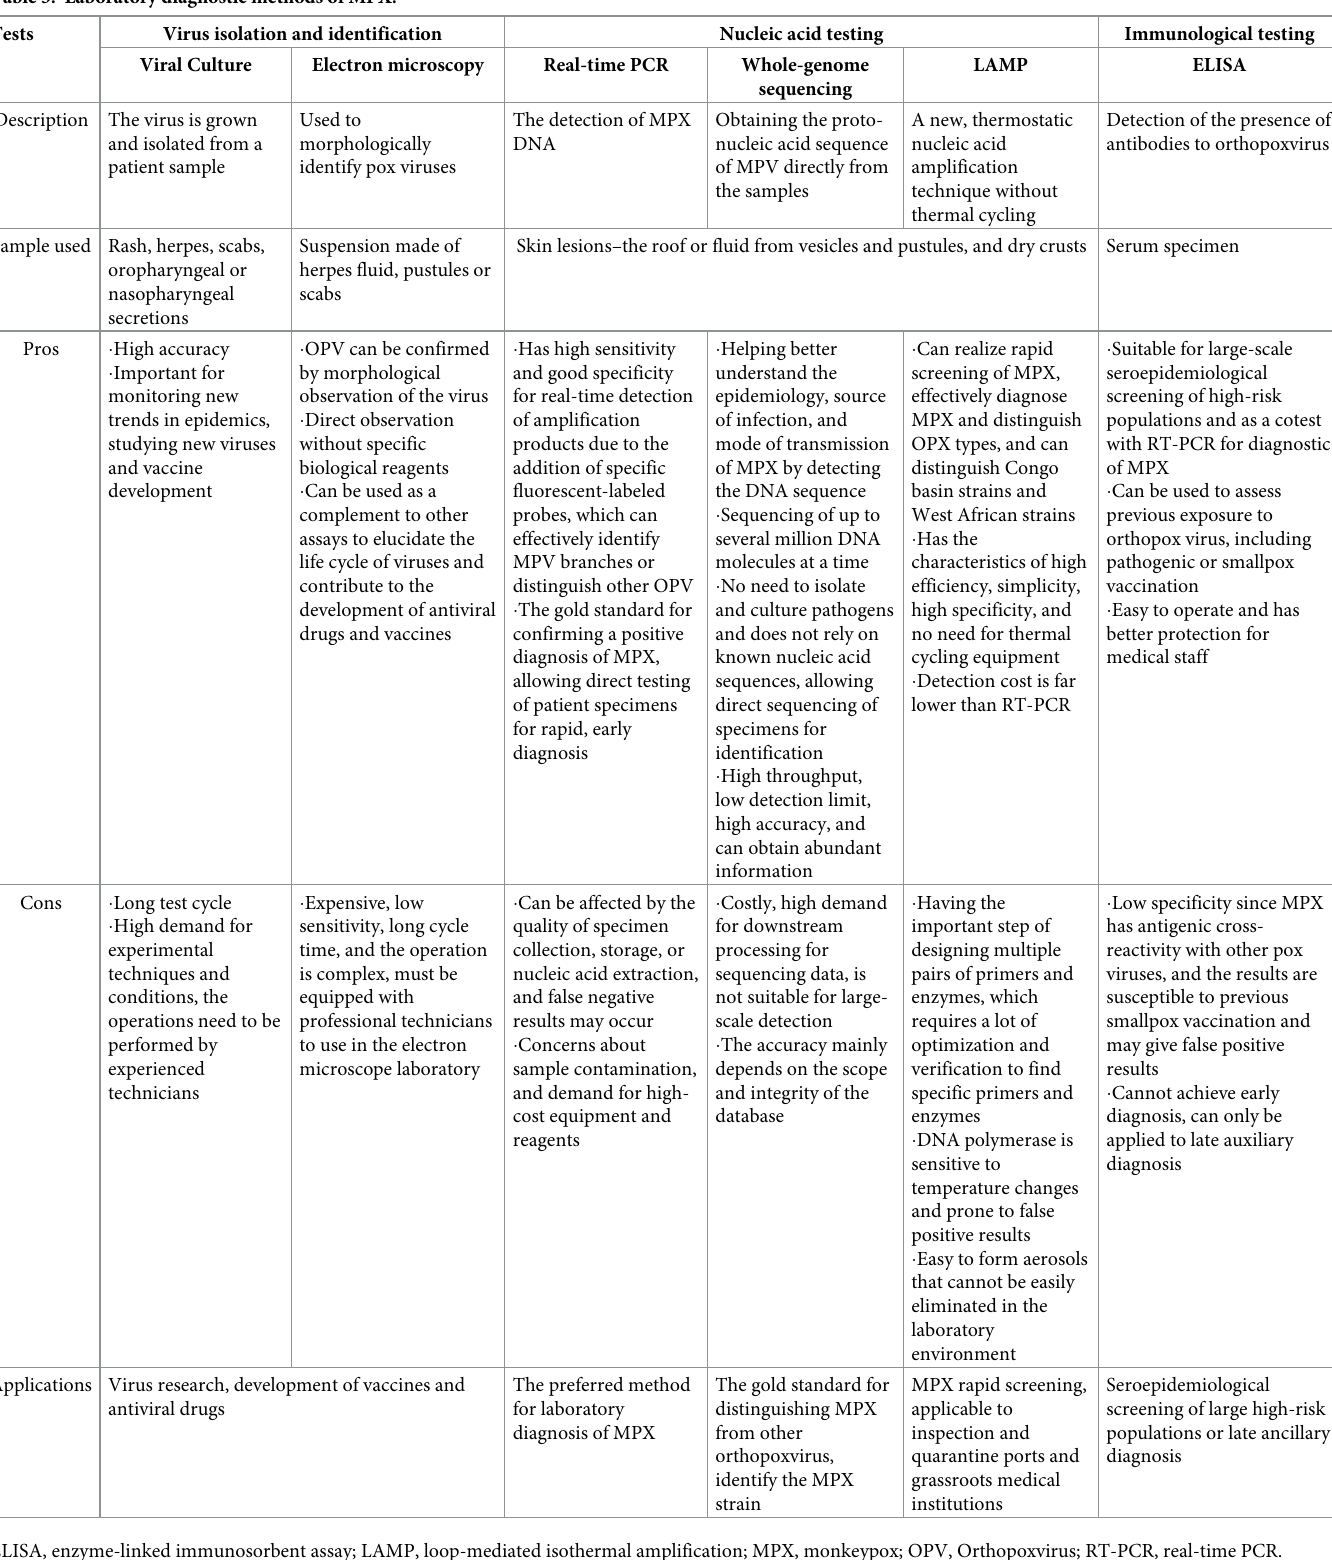
Table 3. Laboratory diagnostic methods of